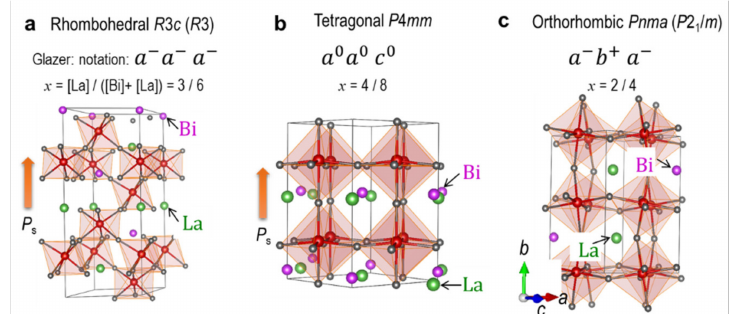
Figure 1. Optimized crystal structures in ( a ) rhombohedral, ( b ) tetragonal, and ( c ) orthorhombic symmetries of the Bi 1 − x La x FeO 3 cells with x = 1/2. The tetragonal cells with x = 0, 1 have octahedral tilt, while those with x = 1/8, 2/8, 3/8, 5/8, and 7/8 have their distinct tilt modes. We adopt a rock-salt structure in an arrangement of Bi and La on the A site as much as possible, the details of which are displayed in Figures S1 and S2. The symmetry in parenthesis denotes the space group taking account of the antiferromagnetic spin configuration.